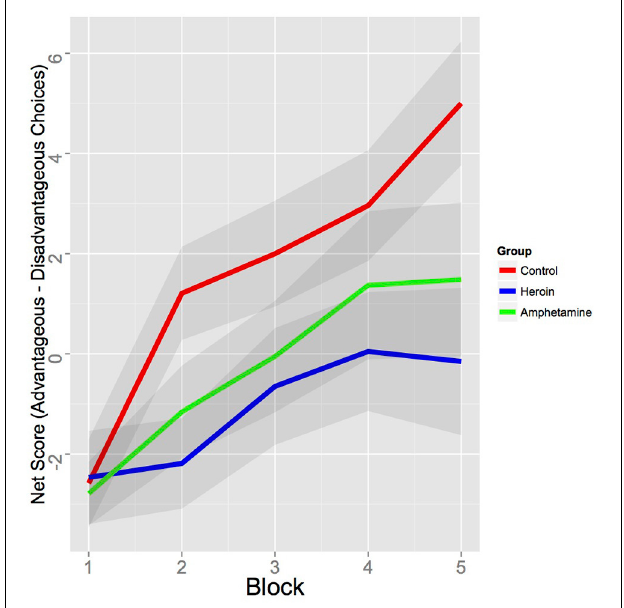
FIGURE 1 | Behavioral performance on the IGT (net score of “advantageous”—“disadvantageous” choices) of amphetamine, heroin, and healthy control groups. The 100 trials were divided into five blocks of 20 trials. Shaded regions indicate ± 1 s.e.m.